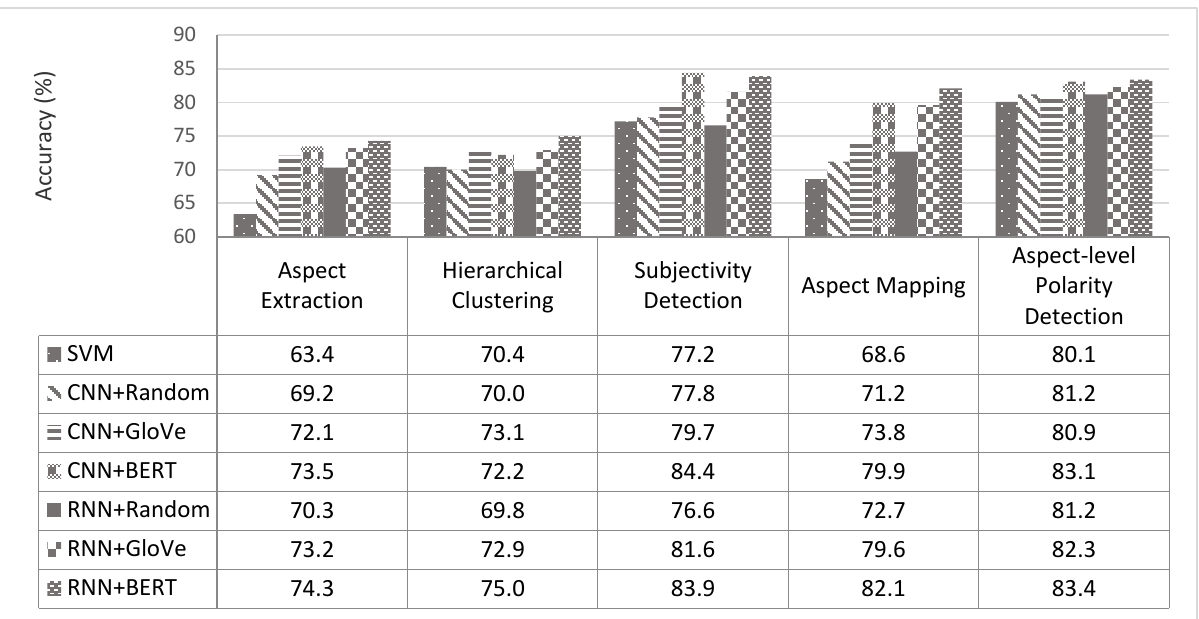
Figure 12. Accuracies from the sampling of different sizes for our dataset.